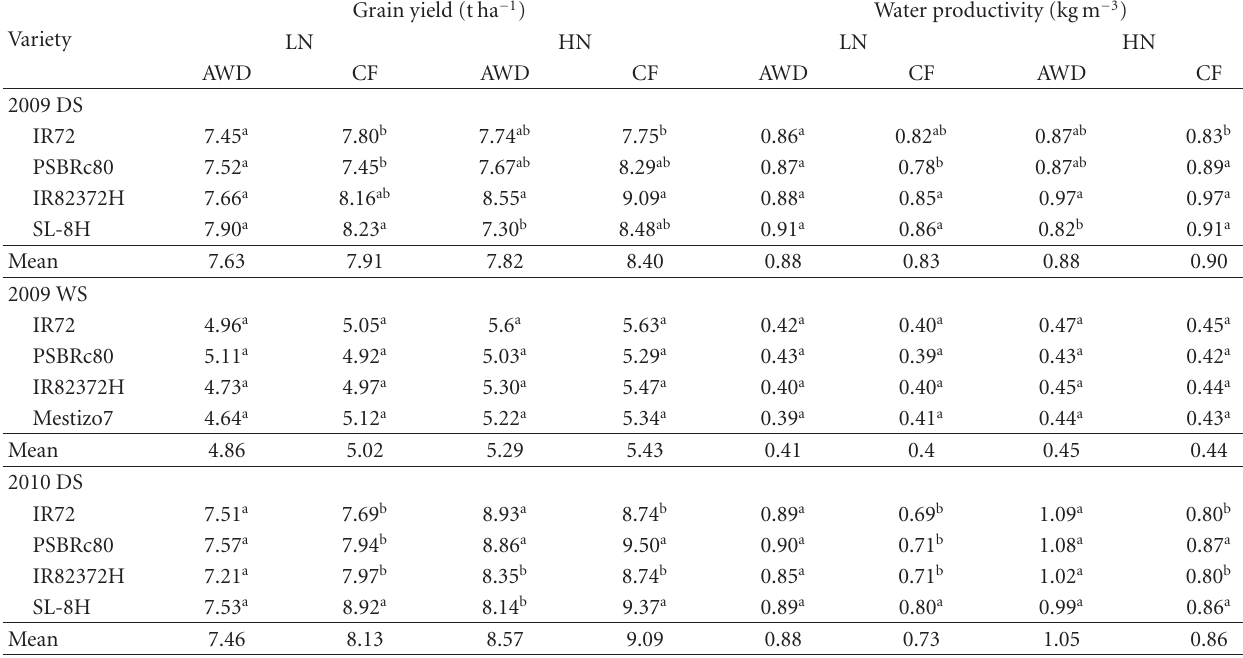
Table 3: Grain yield and water productivity of the four rice varieties grown under two water management treatments and two N rates at the IRRI farm for the three consecutive seasons.